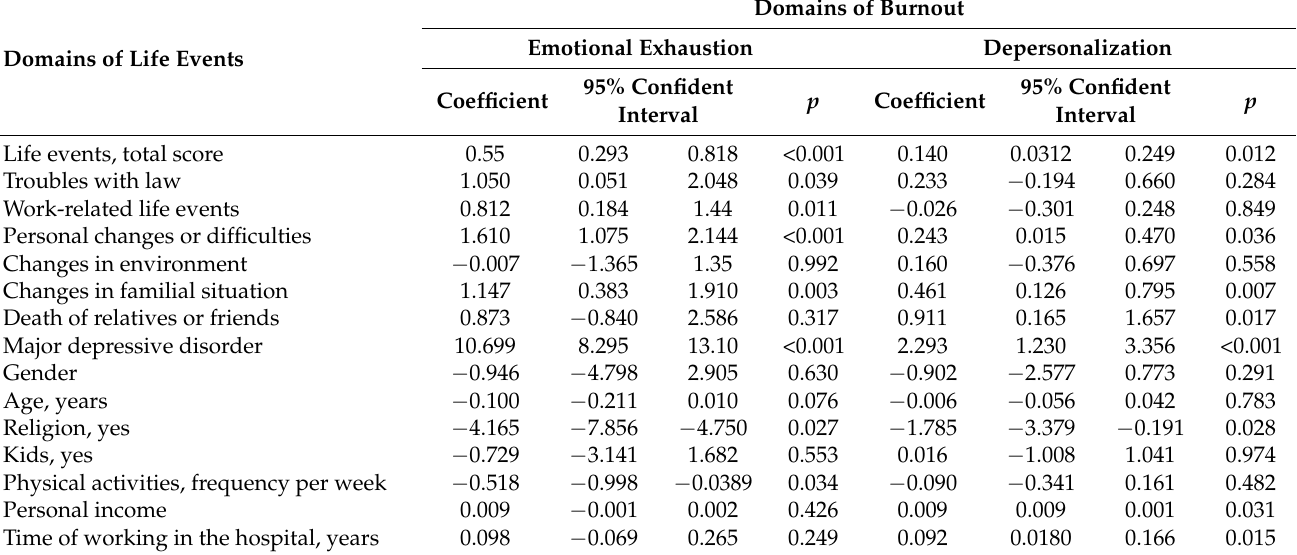
Table 2. Association between domains of life events and domains of burnout in nursing assistants, non-adjusted analysis.